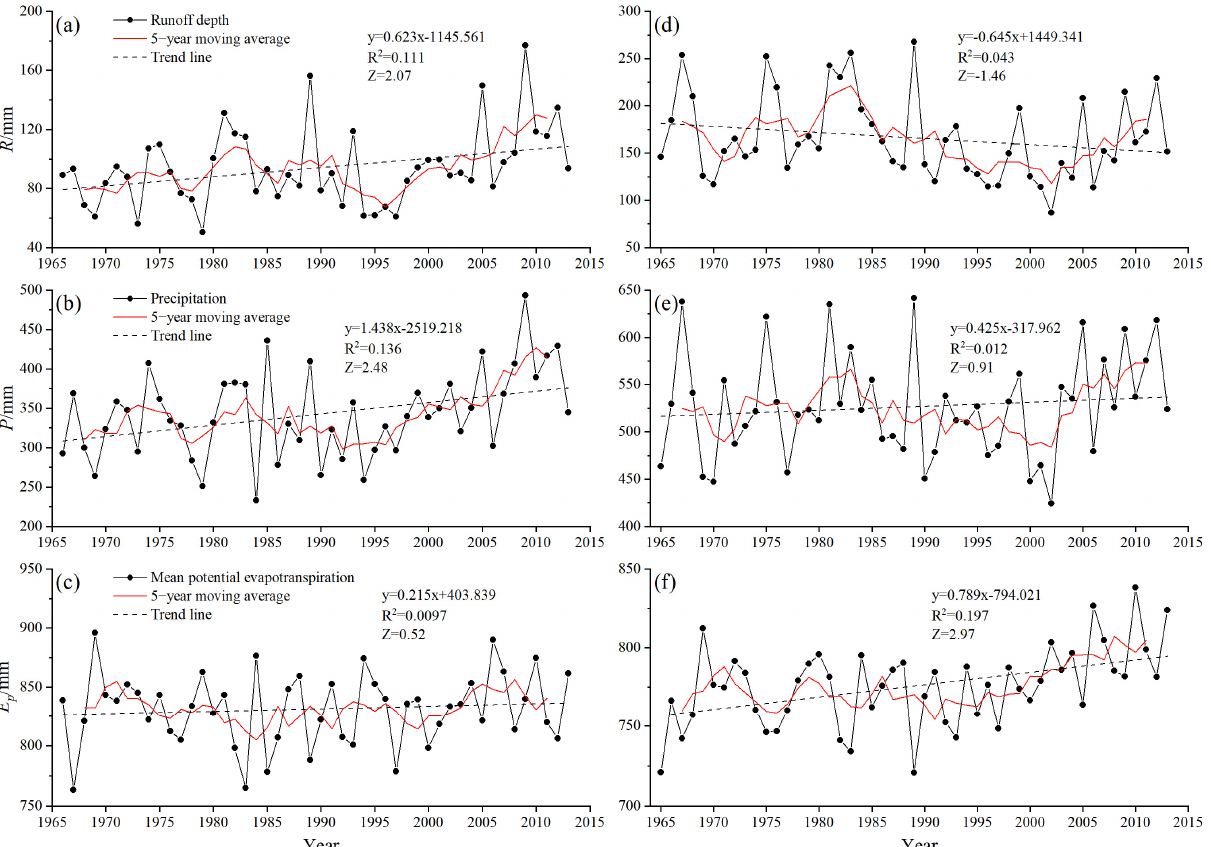
Figure 3. Annual runoff ( R ), precipitation ( P ) and potential evapotranspiration ( E p ) variation characteristics in the SRYZ ( a – c ) and SRYR ( d – f ) (Z represents the statistics of MK test).